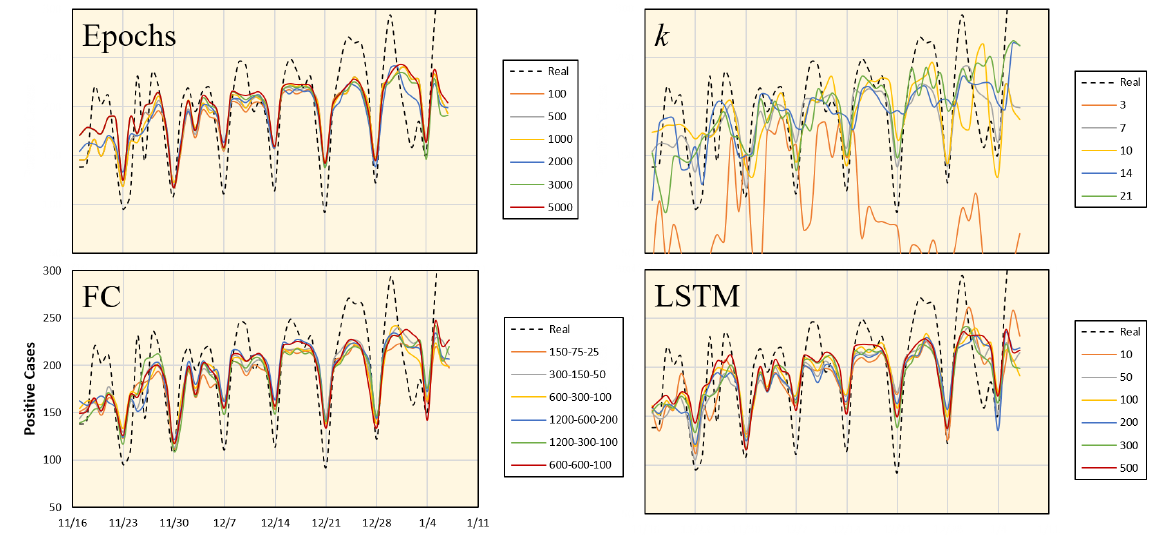
Figure 9. Boxplots demonstrate real (R) and estimated positive cases using Google Cloud forecast (G) and the proposed framework (mobility + meteorological factors) (P all ) and mobility only (P m ) for Tokyo ( top ), Aichi ( middle ), and Osaka ( bottom ). Plots represent seven time periods in chronological order from left to right.